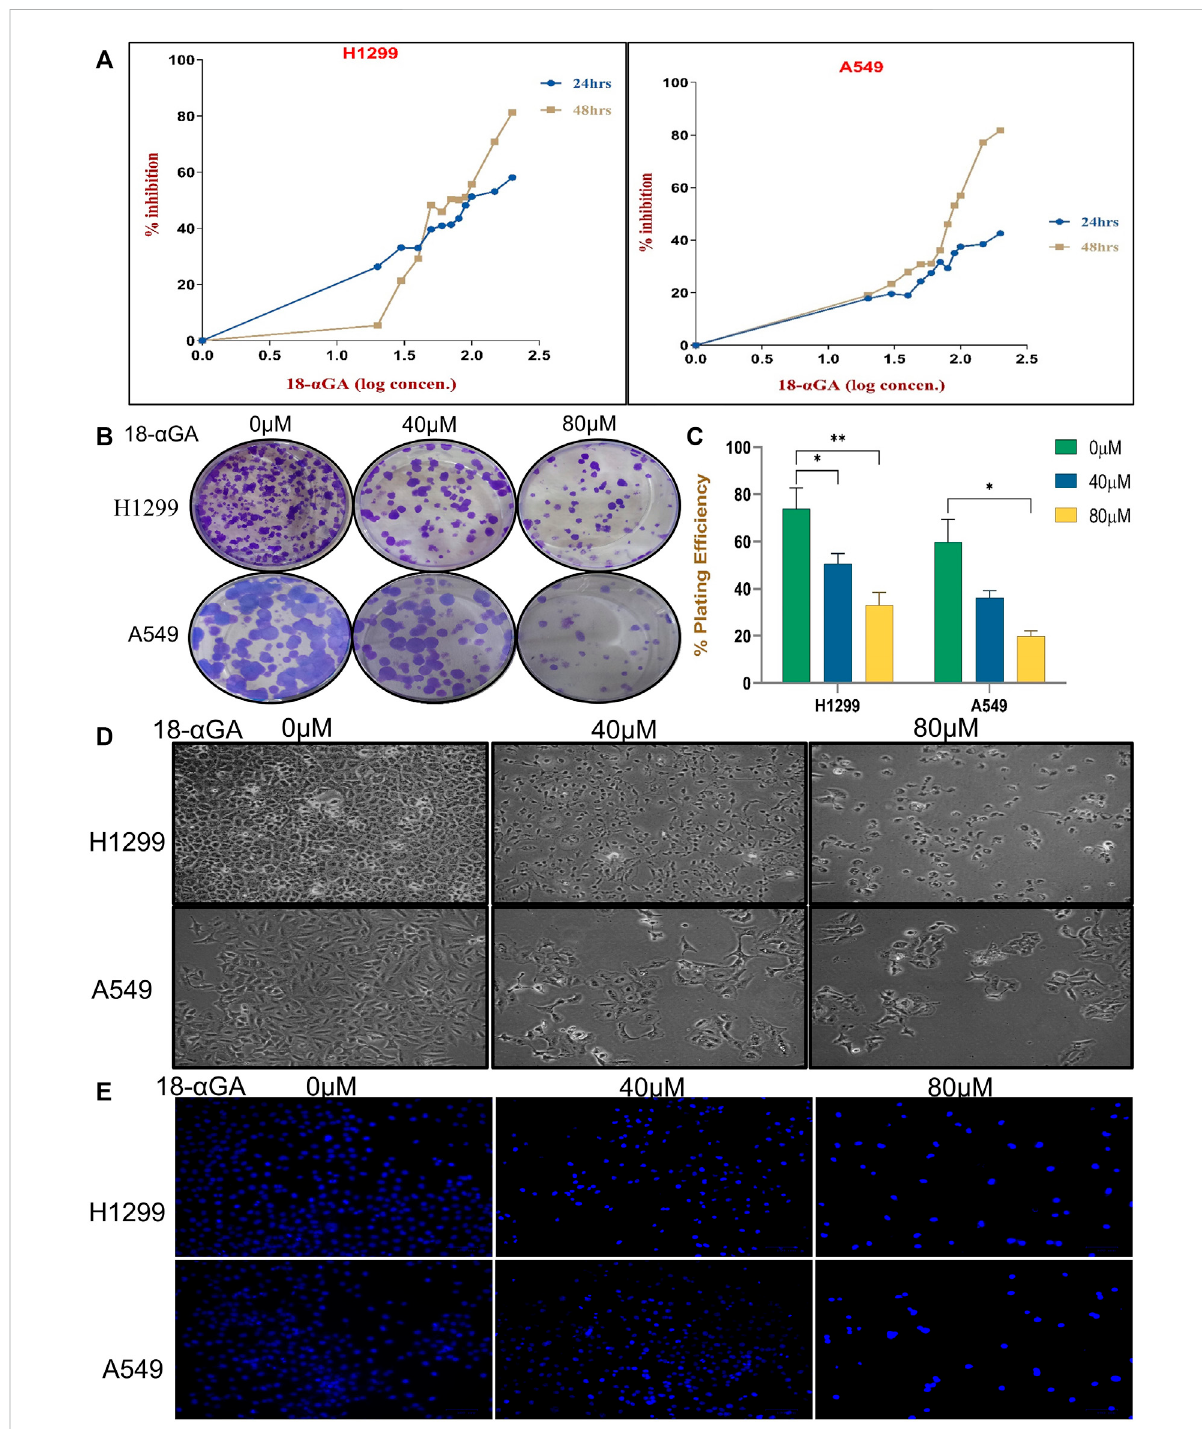
FIGURE 4 (A) Effect of 18- α GA on the viability and proliferation of NSCLC cells. (A) Growth inhibition assessment by the MTT assay upon treatment with variousconcentrations(0,10,20,30,40,50,60,70,80,90,100,150,and200 μ M)of18- α GAattwodifferenttimeintervalsof24hand48 honNSCLC cell lines; H1299 and A549. (B) Images showing colonies appeared after treatment at two different concentrations in both cell lines. (C) % plating ef fi ciency after treatment with 18- α GA, colonies counted by ImageJ ( n = 3, mean ± SD), statistical analysis was done by 2-way Anova followed byTukey ’ sPost-hocmultiplecomparisontest.* p < 0.05,** p < 0.01,*** p < 0.001,**** p < 0.0001. (D) Cellmorphologicalandcytoplasmicchangesin H1299 and A549 cells in the different treatment groups after 48 h (E) DAPI staining shows changes in the fl uorescence levels of cells in different 18- α GA treatment groups (original magni fi cation, ×